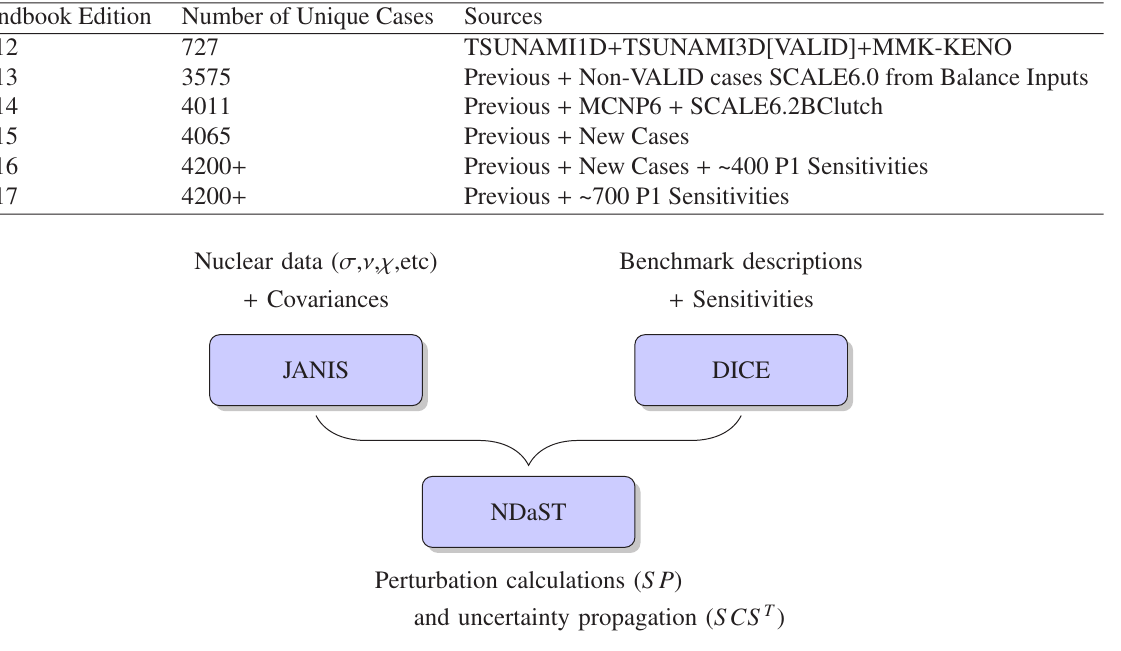
Figure 1. Simplified schematic explaining the database contents within JANIS and DICE and their basic use in the NDaST application.